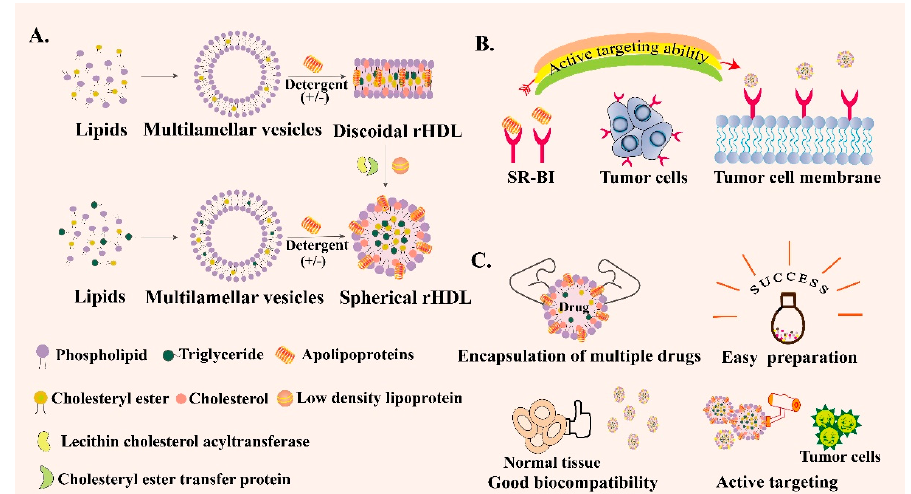
Figure 3. Schematic introduction of reconstituted high-density lipoprotein (rHDL). ( A ) Preparation process of spherical rHDL and discoid rHDL. ( B ) Active targeting ability of rHDL through scavenger receptor class B type I (SR-BI)-mediated specific targeting. ( C ) Various advantages of rHDL as a drug delivery vehicle.